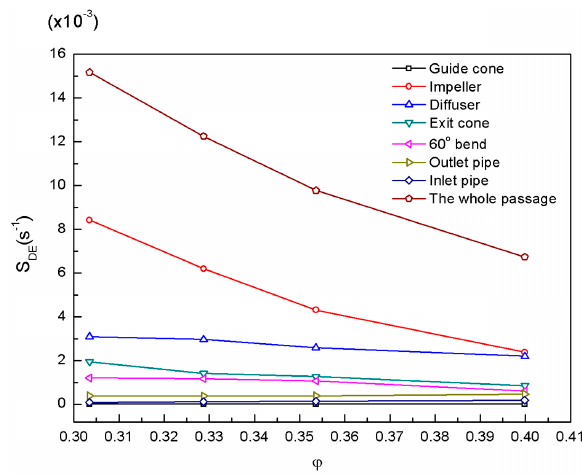
Figure 6. The 𝑆 (cid:3005)(cid:3006) (reflecting the overall entropy generation rate for a domain) of different components Figure 6. The S DE (reflecting the overall entropy generation rate for a domain) of di ff erent components for four discharges for four discharges.